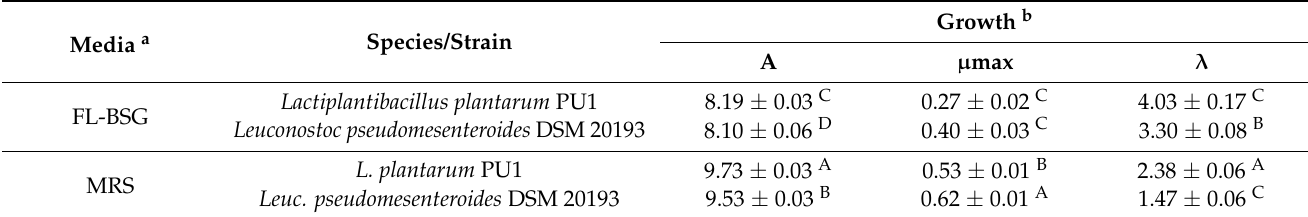
Table 1. Parameters of the growth kinetic of Lactiplantibacillus plantarum PU1 and Leuconostoc pseudomesenteroides DSM 20193 strains during fermentation of Finnish brewers’ spent grain (FL-BSG) and Rich De Man, Rogosa and Sharpe (MRS) media at 30 ◦ C for 24